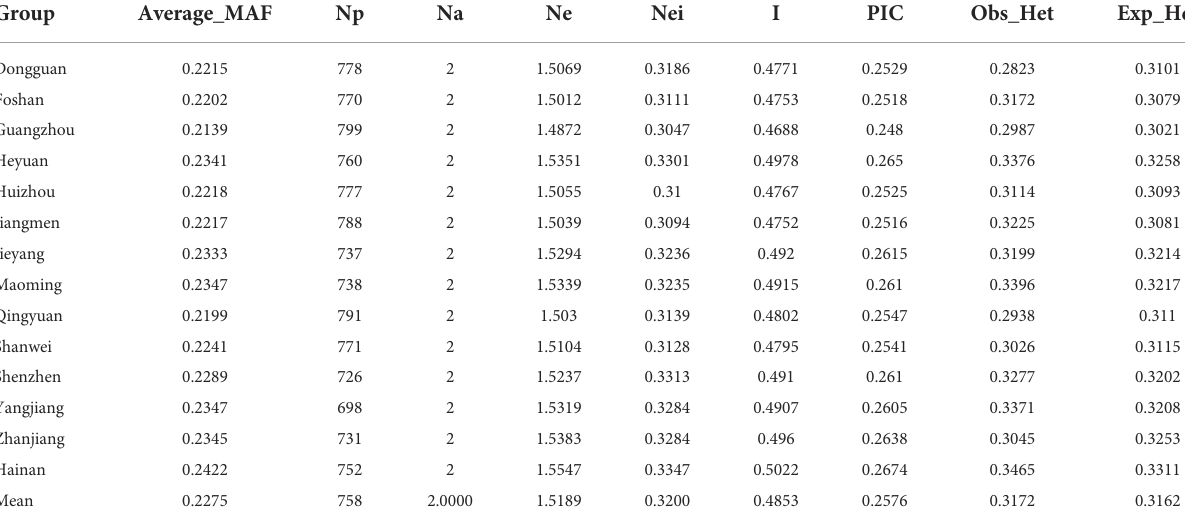
TABLE 1 Genetic diversity parameters of O. ru fi pogon in different collection city. Group Np